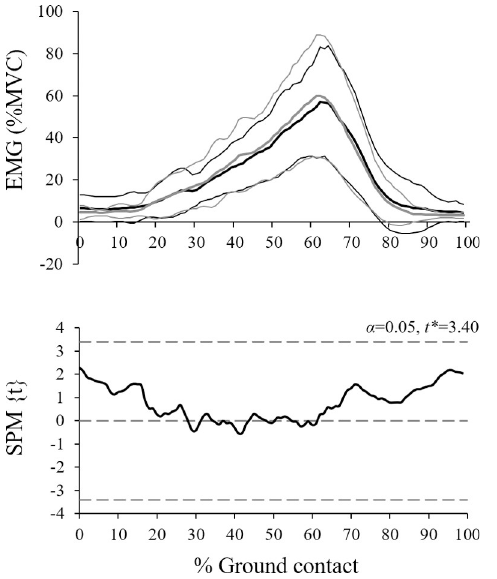
Fig 3. Mean ± s.d. (thick and thin lines, respectively) GM EMG amplitude pre (black) and post (grey) across the ground contact phase. EMG amplitude is relative to the maximum amplitude achieved across all plantarflexion MVC trials. SPM analysis demonstrates no change in muscle activation during walking as a result of the training interventions.